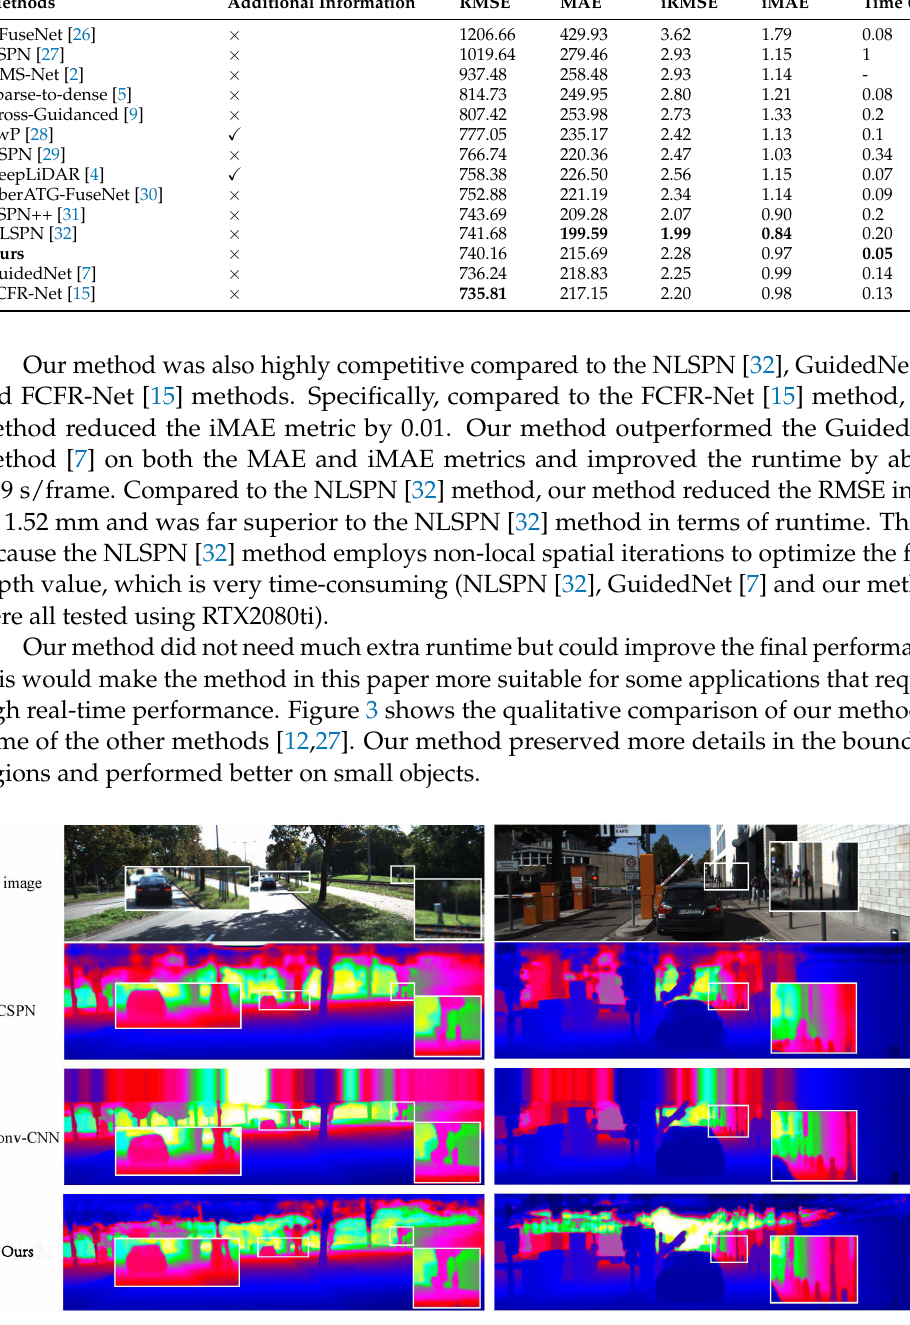
Figure 3. The qualitative comparisons were performed by CSPN [26] and NConv-CNN [12] using the KITTI testing dataset. The results are from the KITTI depth completion leaderboard, in which depth images are colorized along with the depth range. Our method (framed by the white boxes) achieved a better performance and recovered better